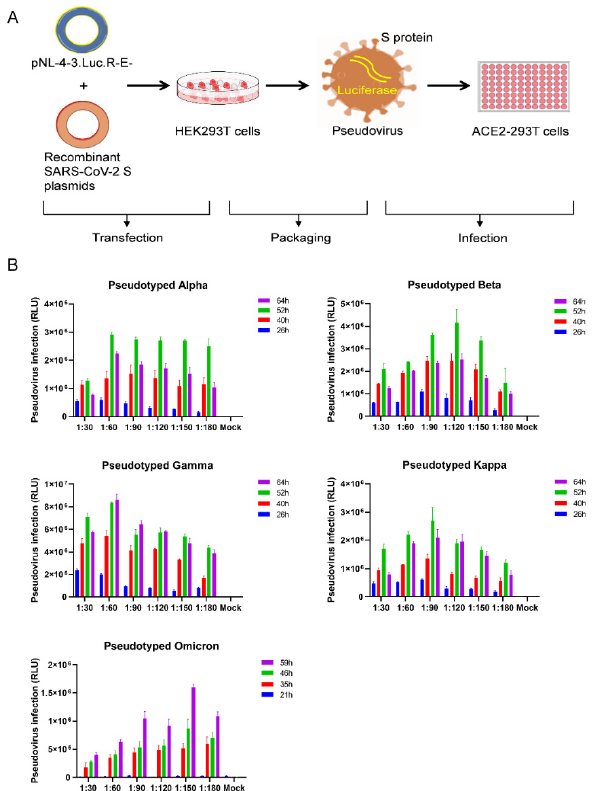
Figure 2. Optimization of SARS-CoV-2 variants pseudovirus production. ( A ) Schematic representation of the SARS-CoV-2 variants pseudovirus production and neutralization assay. The HIV backbone vector pNL4-3.Luc.R-E- plasmids were cotransfected with pCAGGS-Alpha-S, pCAGGS-Beta-S, pCAGGS-Gamma-S, pCAGGS-Kappa-S, or pCAGGS-Omicron-S, respectively into HEK293T cells to package the pseudotyped lentiviral particles. The supernatants containing SARS-CoV-2 variants pseudovirus with S protein were collected and then ACE2-293T cells were used to measure the pseudoviral titer. ( B ) Effect of the ratio of the recombinant S protein expression plasmids to the HIV backbone plasmids and the collection time for pseudovirus particles on the production of pseudovirus. Cells without pseudovirus infection were used as background. The data were expressed as mean relative luciferase units (RLU) ± standard deviation (SD) of 3 parallel wells in 96-well culture